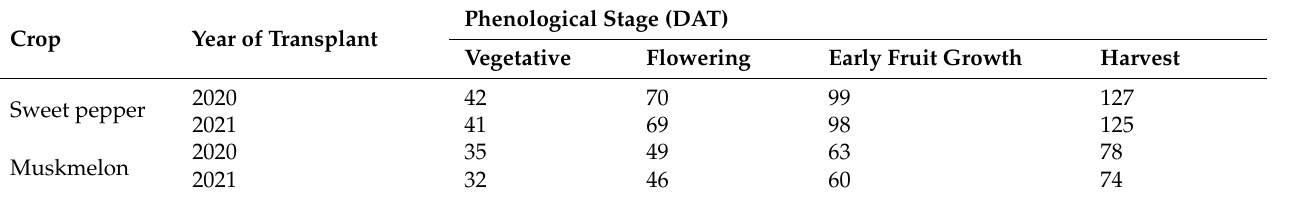
Table 2. Measurement dates of proximal optical sensors based on the day after transplanting (DAT). Crop Year of Transplant